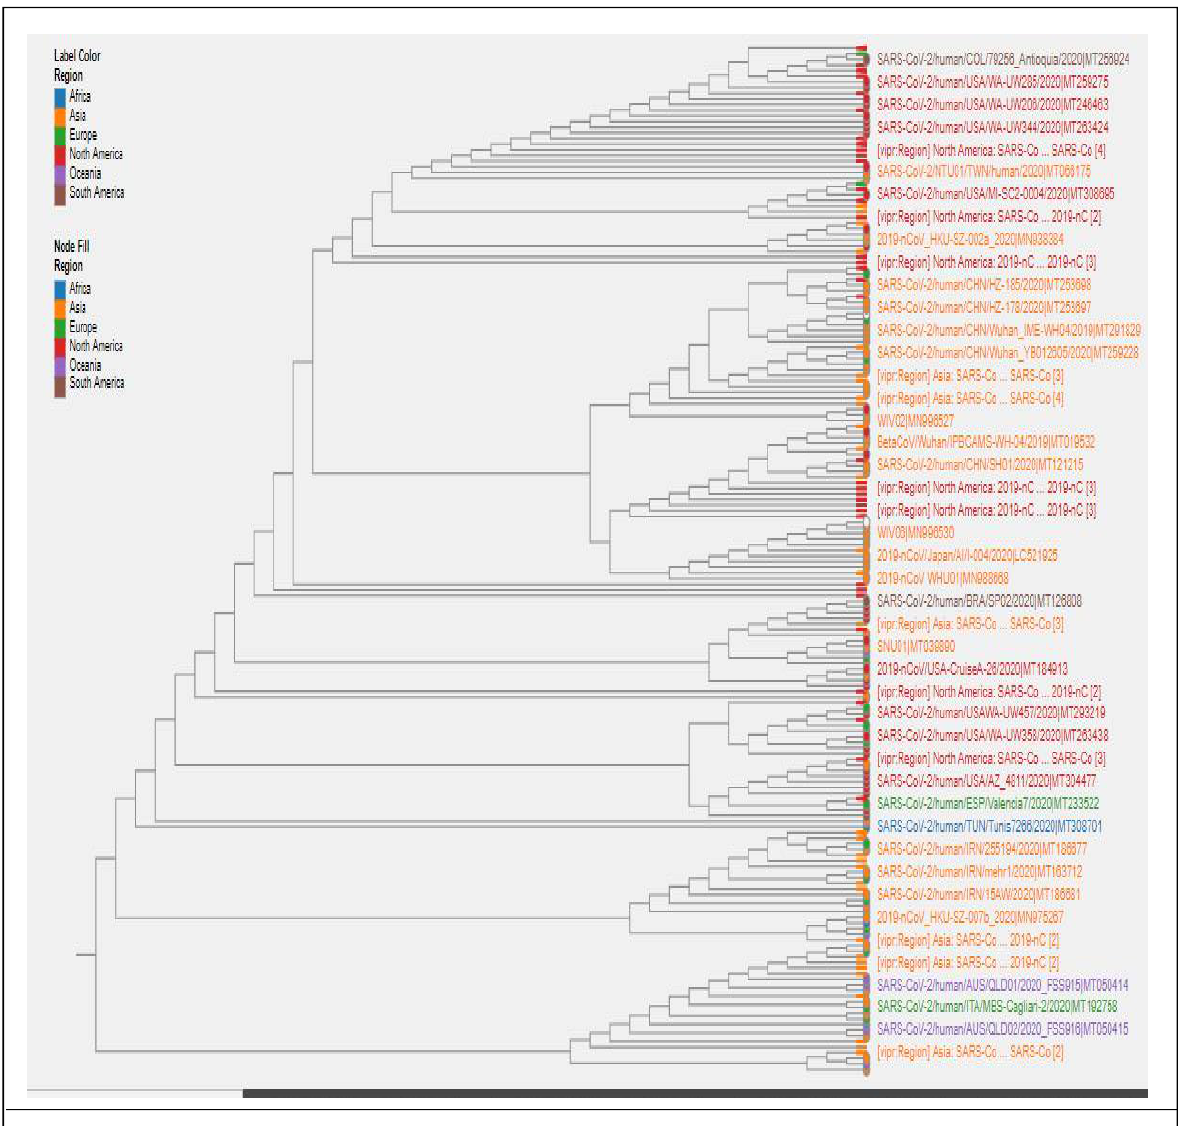
Figure 4: A Phylogenetic tree showing the COVID-19 strains across the